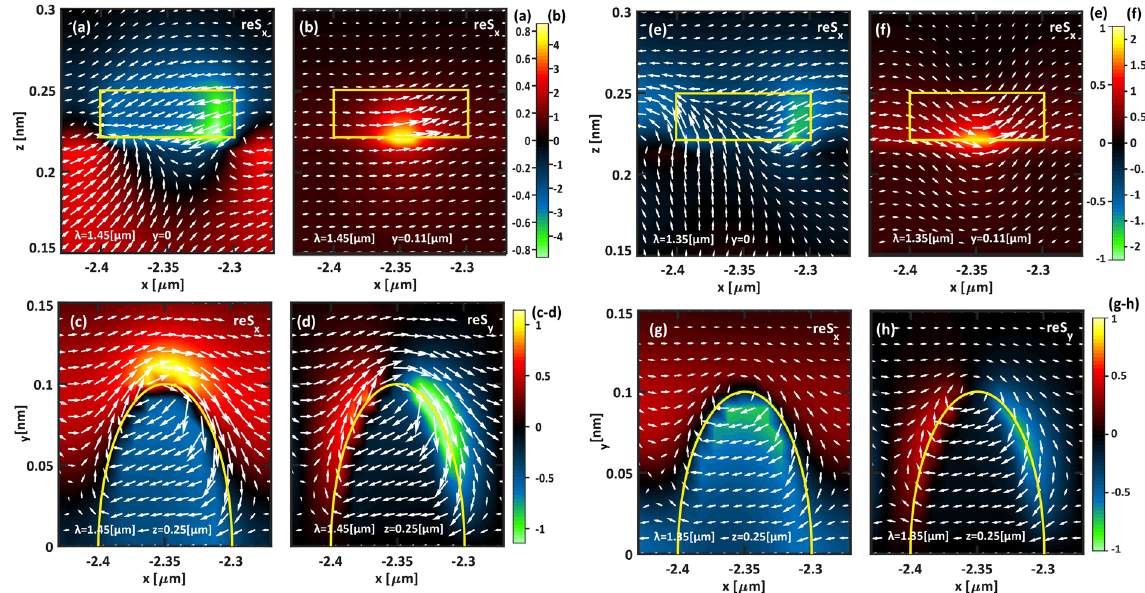
Figure 3. Poynting vector maps [arb. u.] and vector fields when: ( a – d ) λ = 1.450 μ m and ( e – h ) λ = 1.350 μ m . In ( a ),( b ),( e ),( f ) the Poynting vector is plotted as a function of x - and z -coordinates, when: ( a ),( e ) y = 0 and ( b ),( f ) y = 110 nm . In ( c ),( d ),( g ),( h ) the Poynting vector is plotted as a function of x - and y-coordinates, when z = 250 nm and y > 0. The yellow curves display the MNP contour with respect to the